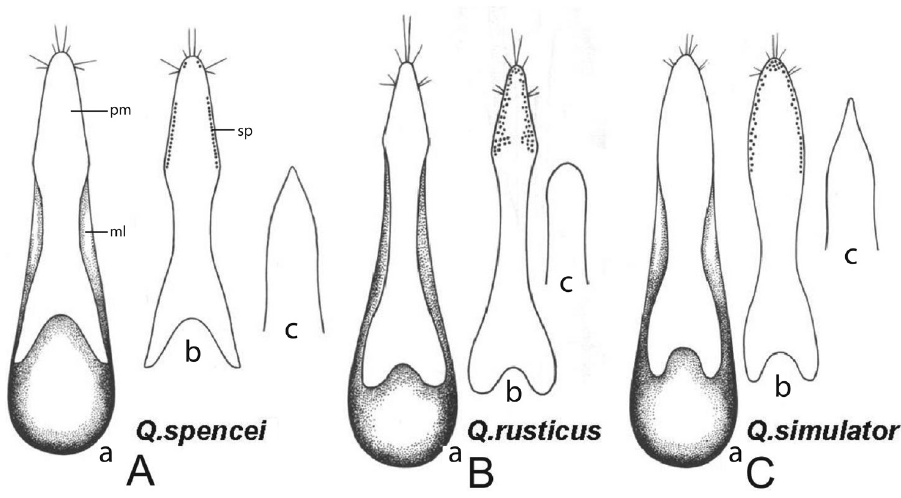
Figure 2. Male genitalia of A Q.spencei B Q.rusticus , and C Q.simulator a aedeagus, ventral aspect, ml: median lobe, pm: paramere b paramere, dorsal aspect, sp: sensory peg setae c) apex of median lobe, ventral aspect. Illustrations of Q.rusticus and simulator from Smetana